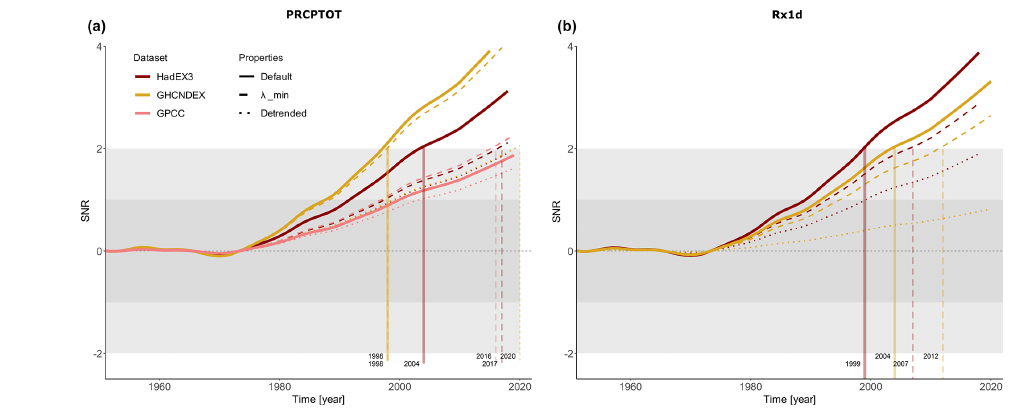
Figure 5. SNRs of mean total precipitation (PRCPTOT) (a) and extreme precipitation (Rx1d) (b) forced response estimates in GHCNDEX, HadEX3 and GPCC, including sensitivities to regularisation parameter (dashed) and global mean detrending (dotted). Exceedance of an SNR of 2 implies emergence. Signal is defined as forced response estimate regressed onto 21-year LOWESS filtered global mean surface temperature, noise as residuals of this